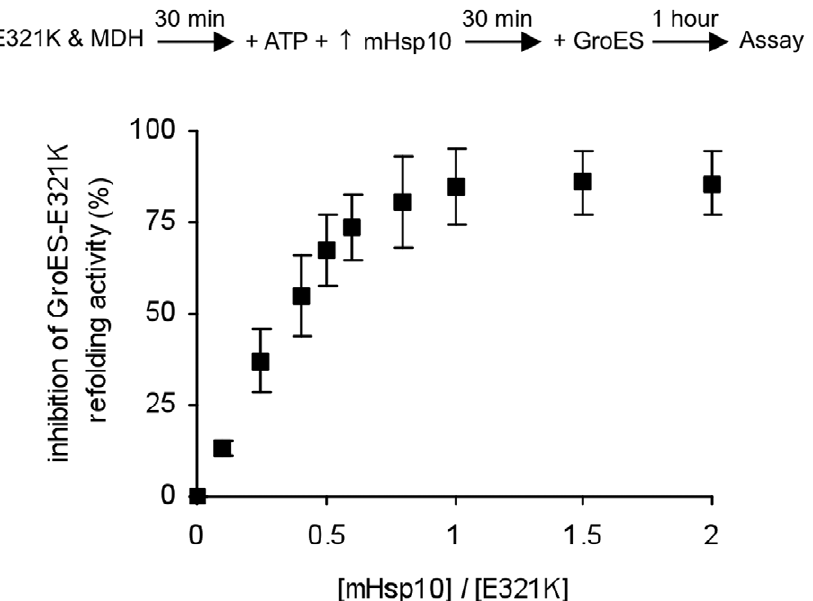
Figure 3. Inhibition of GroES-E321K refolding activity by mHsp10. A binary complex of E321K and HCl-denaturated MDH was pre-incubated for 30 min in the presence of increasing concentrations (from 0 to 20 m M) of mHsp10 and 2 mM ATP before adding 20 m M GroES. MDH activity was measured 1 hour following the addition of GroES. % inhibition=100*[(A o –A i )/A o ]. A o represents the activity level in the absence of mHsp10, and A i represents the activity level at each mHsp10